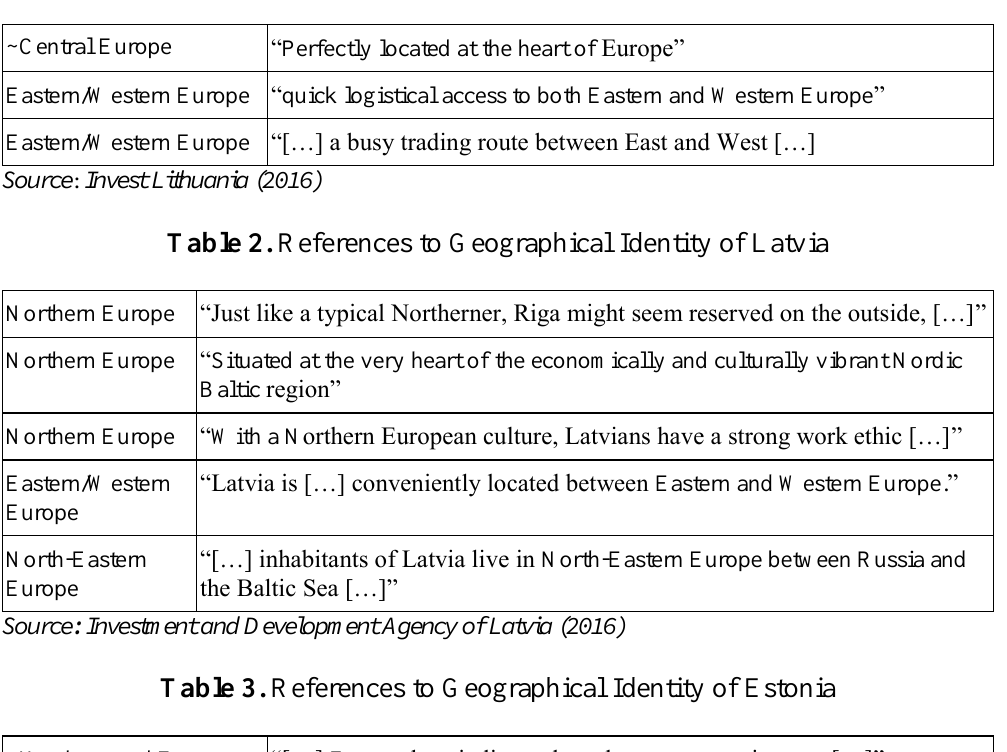
Table 1. References to Geographical Identity of Lithuania